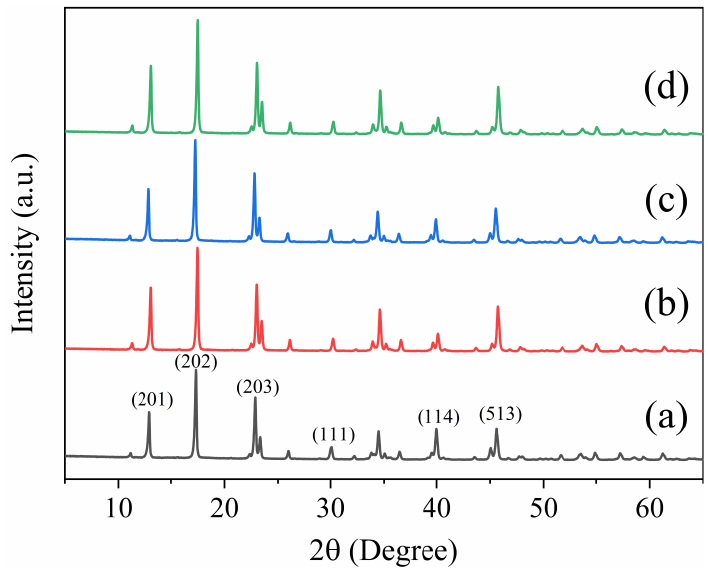
Figure 3. X-ray diffraction (XRD) curves, of ( a ) Unmodified MOSw, ( b ) MOSw@SiO 2 , ( c ) MOSw@SiO 2 @KH570, ( d ) MOSw@SiO 2 @PDA.